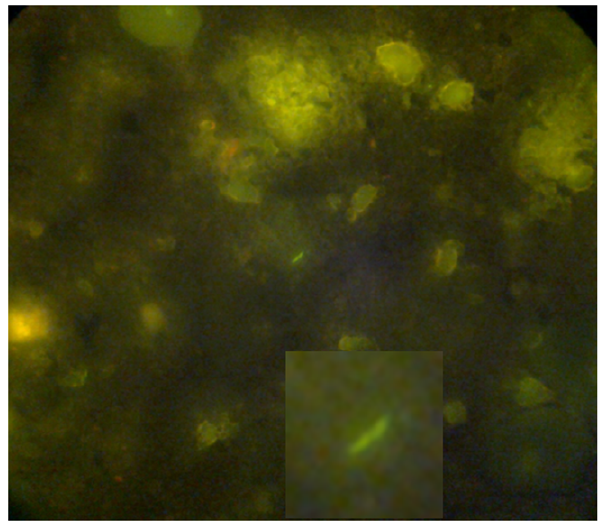
Figure 3. A 5MP image of an auramine stained sputum sample captured in our European laboratory. The image was captured with a Nokia C3 mobile phone on a Nikon AFX-IIA microscope (field 40 6 ). Mycobacterium tuberculosis is depicted in the center and a magnification of the bacterium is shown at the bottom of the image. the Internet, Figure 4 (below). We were able to enlarge the image or specific parts of the image and reply by means of a text message.